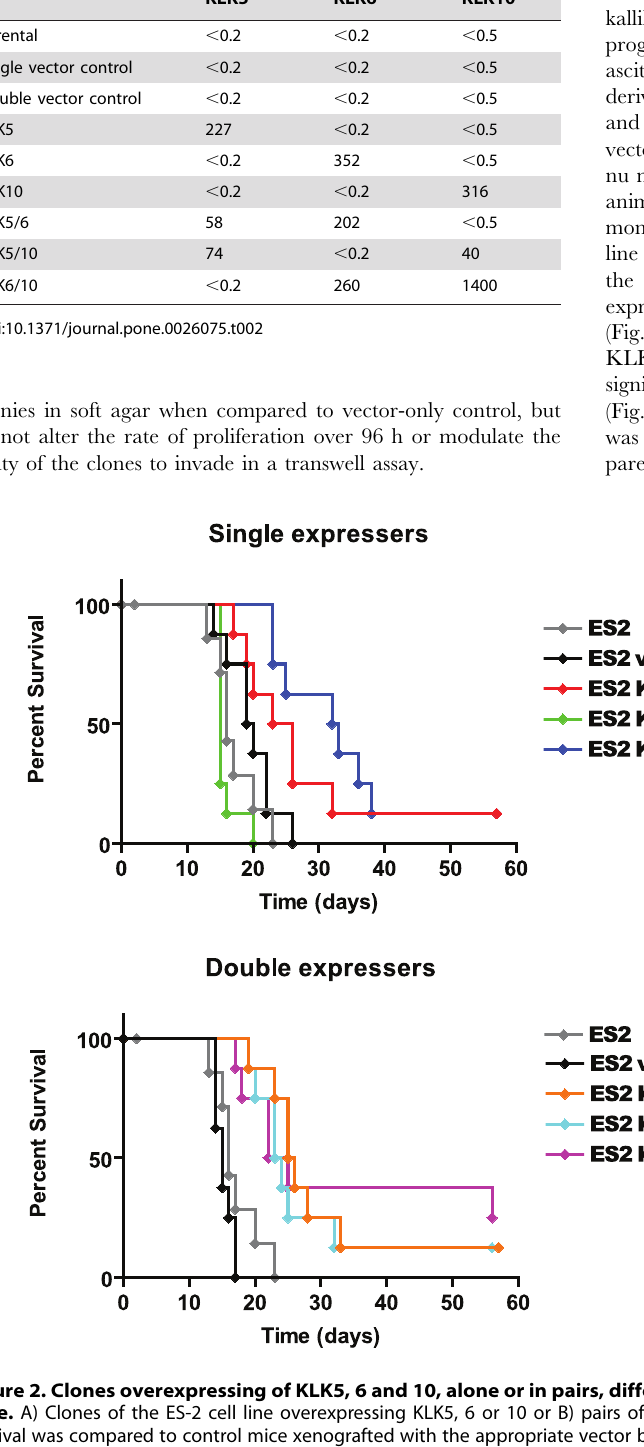
Figure 2. Clones overexpressing of KLK5, 6 and 10, alone or in pairs, differentially affect survival times when xenografted into nude mice. A) Clones of the ES-2 cell line overexpressing KLK5, 6 or 10 or B) pairs of KLK5/6, KLK5/10 and KLK6/10 were injected IP in nude mice and survival was compared to control mice xenografted with the appropriate vector backbone clones. The results are shown as a Kaplan-Meier plot, and significance using a logrank test versus appropriate control was inferred at p , 0.05. * denotes p , 0.05, ** denotes p , 0.01, and *** p ,